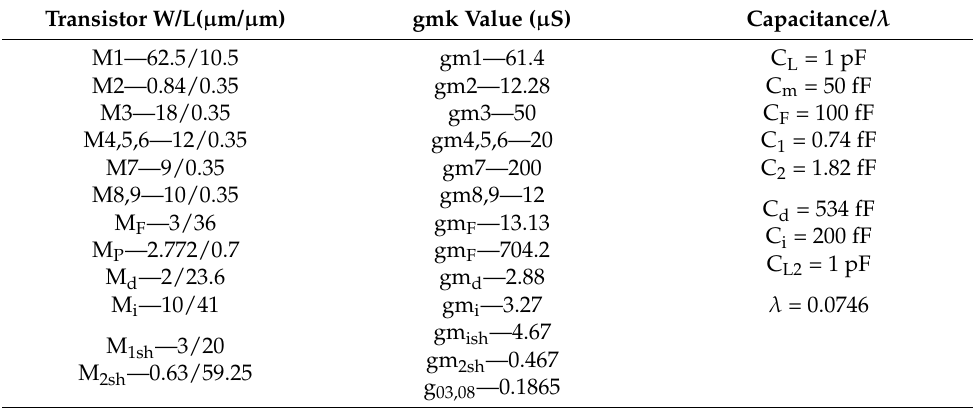
Table 2. Design parameters of the proposed Front-End